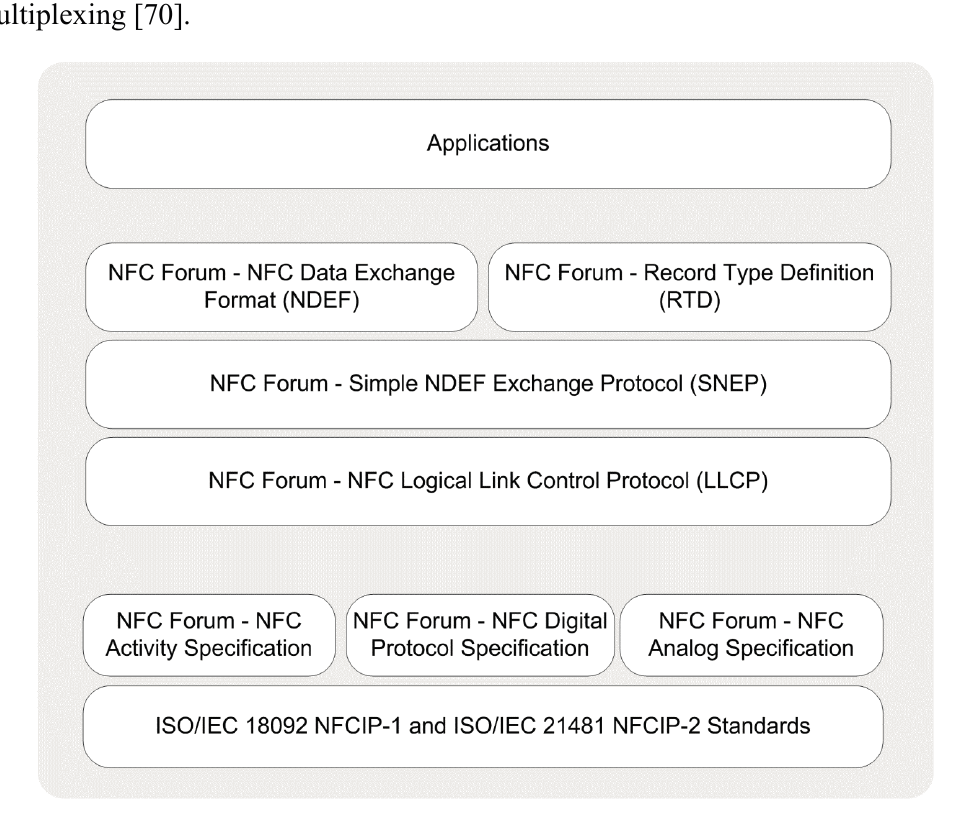
Figure 4. Protocol stack of peer-to-peer operating